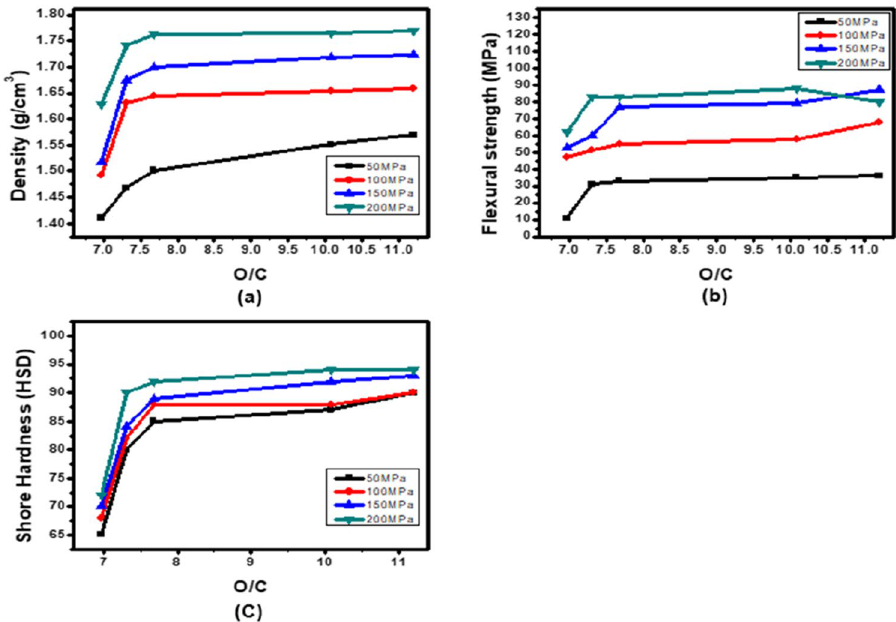
Figure 7. Changes in ( a ) density, ( b ) flexural strength, and ( c ) shore hardness due to O/C of the high-density carbon block after carbonization.